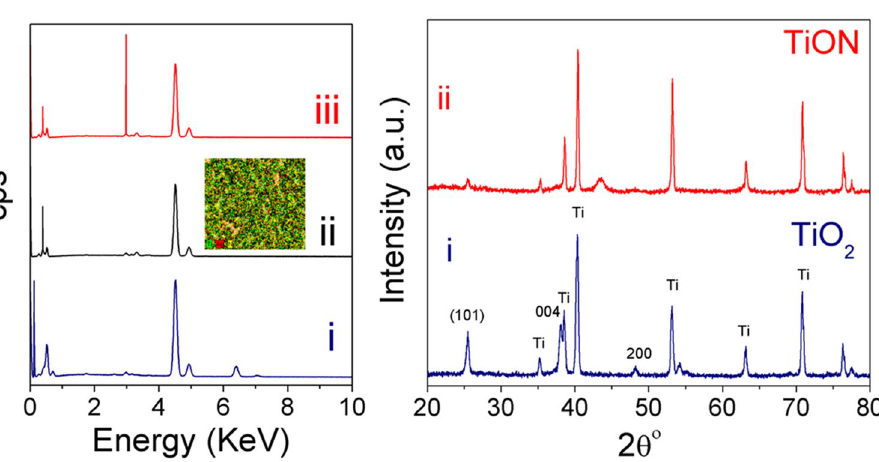
Figure 2. ( a ) EDX and ( b ) GAXRD spectra of (i) air-annealed, (ii) ammonia-annealed, and (iii) Ag-decorated ammonia-annealed samples. The inset in Fig. 2a is the EDS mapping for Ag